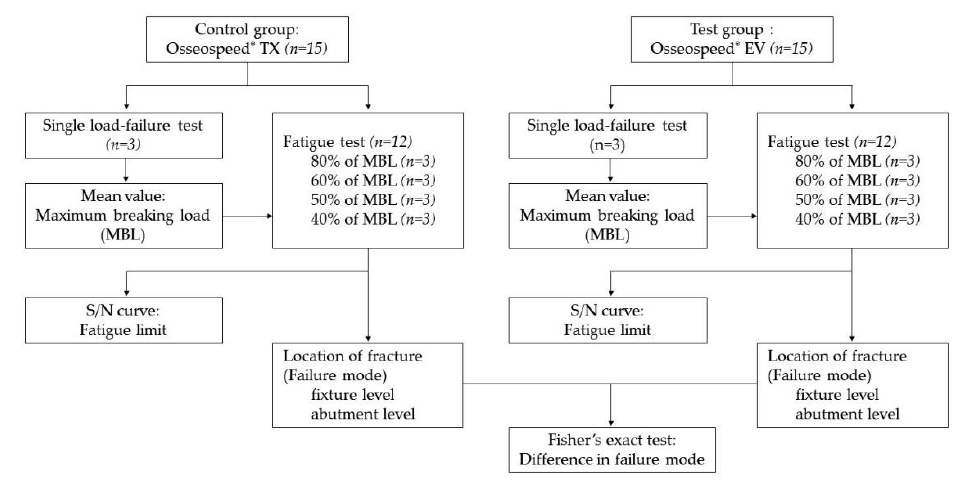
Figure 1. Overall flow of the experiment.